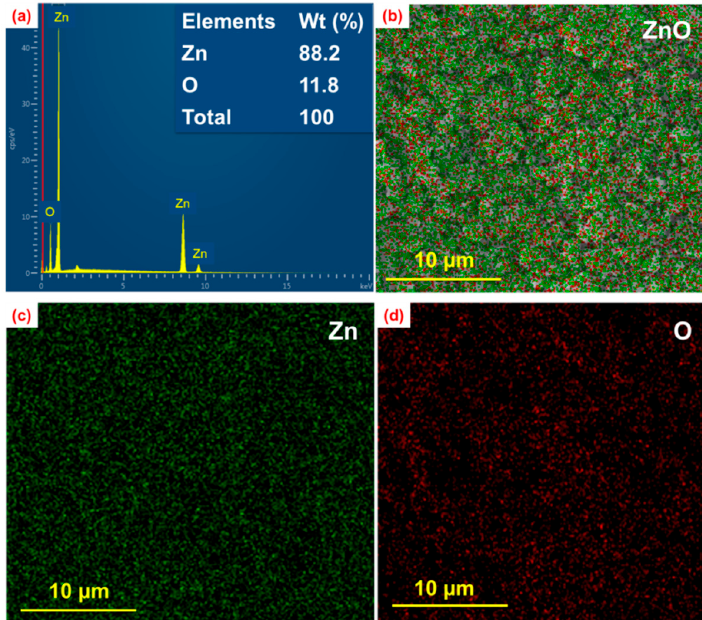
Figure 5. ( a , b ) EDS mapping showing the distribution of ZnO nanoparticles, ( c ) zinc, and ( d ) oxygen synthesized at an applied potential of 16 kV, a distance of 12 cm, a flow rate of 1 mL/h, and a calcination temperature of 600 °C.